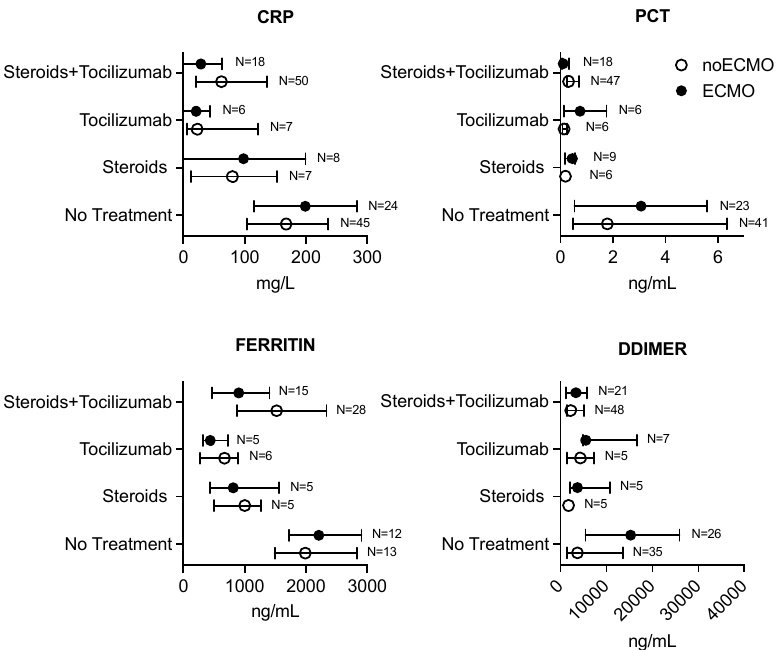
Figure 2. Markers of inflammation with or without steroids and Tocilizumab therapy in COVID-19 patients with ARDS who required or not ECMO support. Table 2. Mixed-effects linear regression model involving the independent variables related to the log-lymphocyte count in both study groups, adjusted for